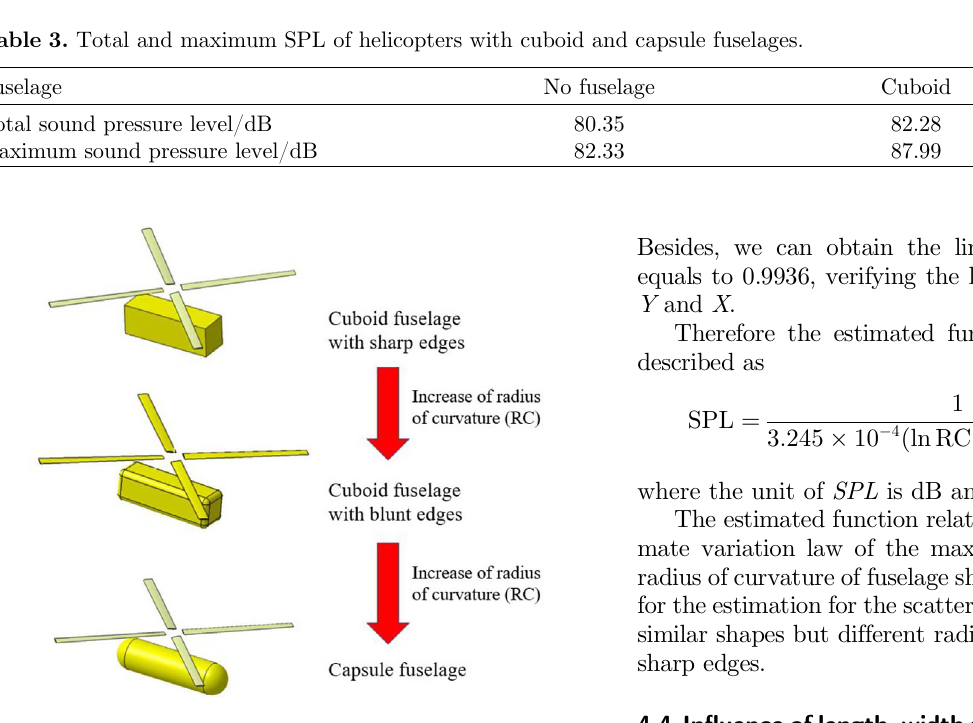
Figure 13. Effects of the increase of RC of fuselage sharp